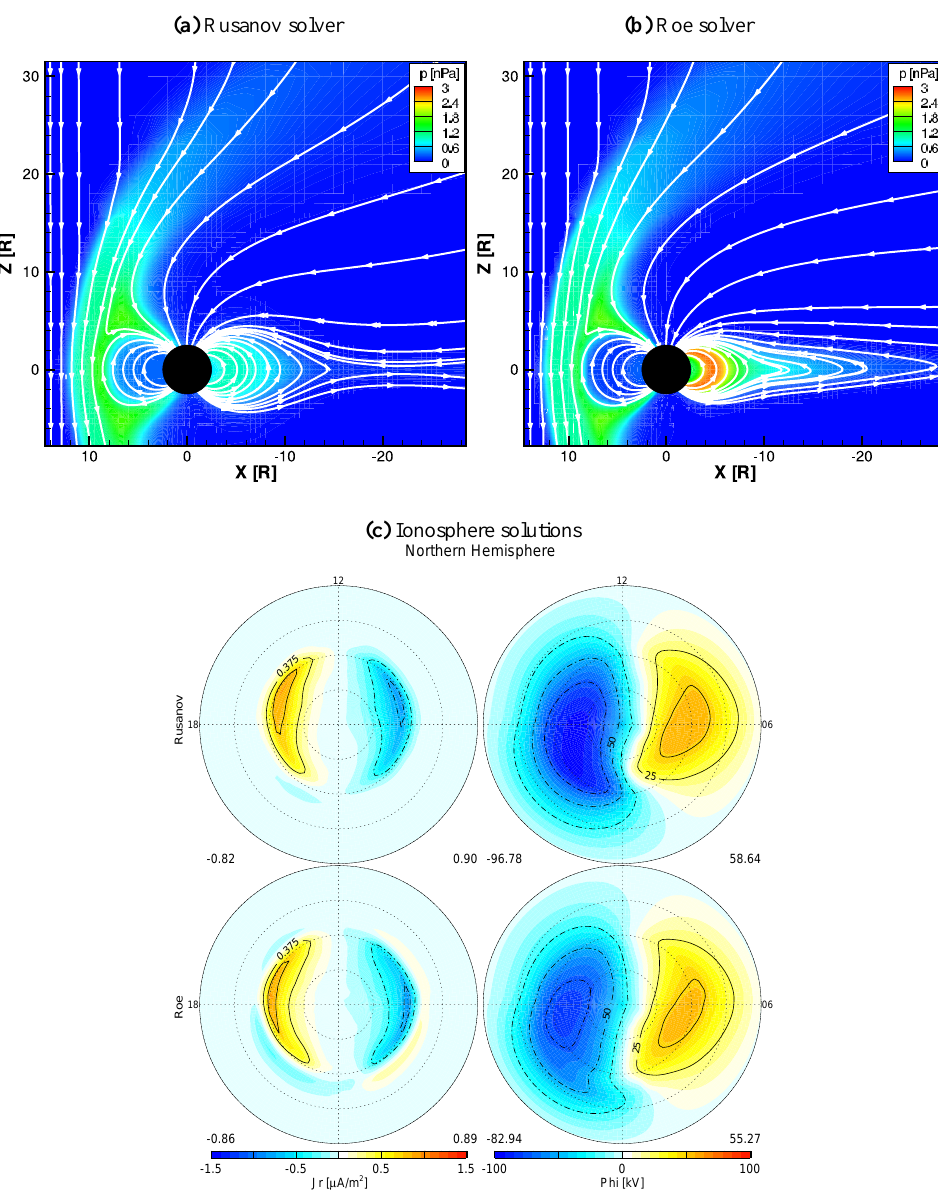
Fig. 6. Top: plots of the pressure color contours in the Y = 0 plane, with traces of the magnetic field in this plane overplotted. The simulation results using the Rusanov (Roe) solver is on the left (right). Bottom: plots of the field-aligned current (left) and ionospheric potential (right) for the Rusanov (top) and Roe (bottom) simulation. The color contours are the same for each pair of Rusanov and Roe